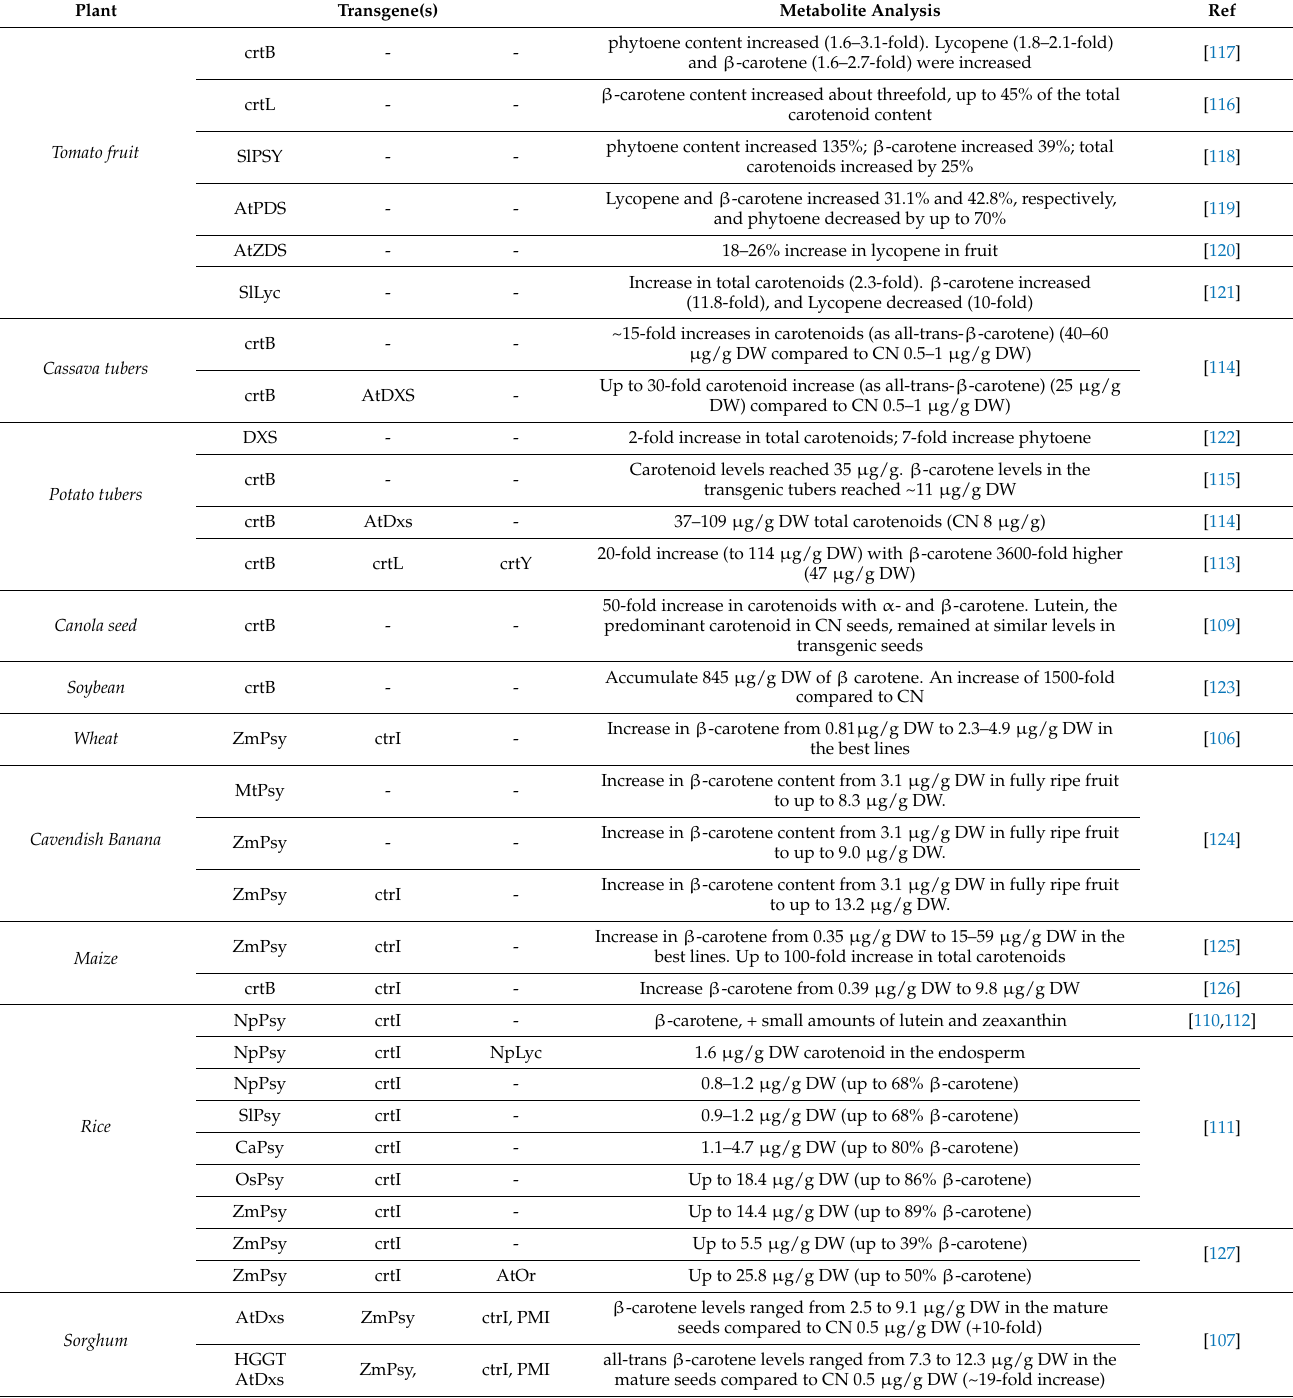
Oryza sativ (Os); Solanum lycopersicum (Sl); Capsicum annum (Ca); Arabidopsis thaliana (At); Zea mays (Zm); Narcissus pseudonarcissus (Np); Hordeum vulgare (Hv); Musa troglodytarum x acuminate (Mt). CN =